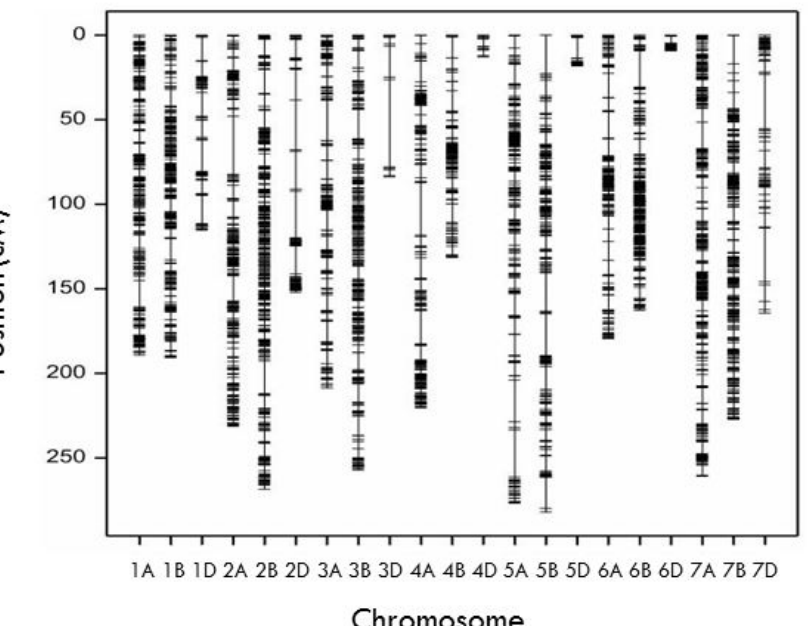
Figure 2. Linkage map constructed from genotyping-by-sequencing in a RIL population derived from a cross between #49 and Yecora Rojo. The genetic distances (cM) of markers are shown on the left side.